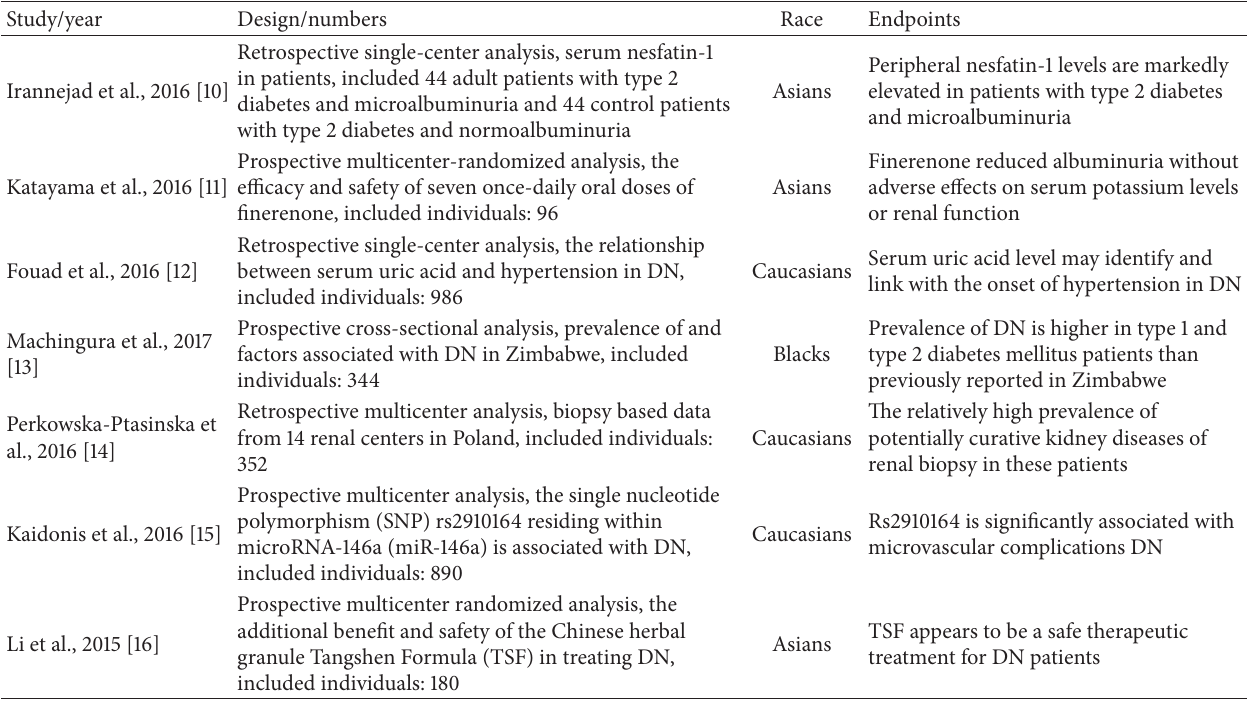
Table 1: Studies about reported new future therapies of